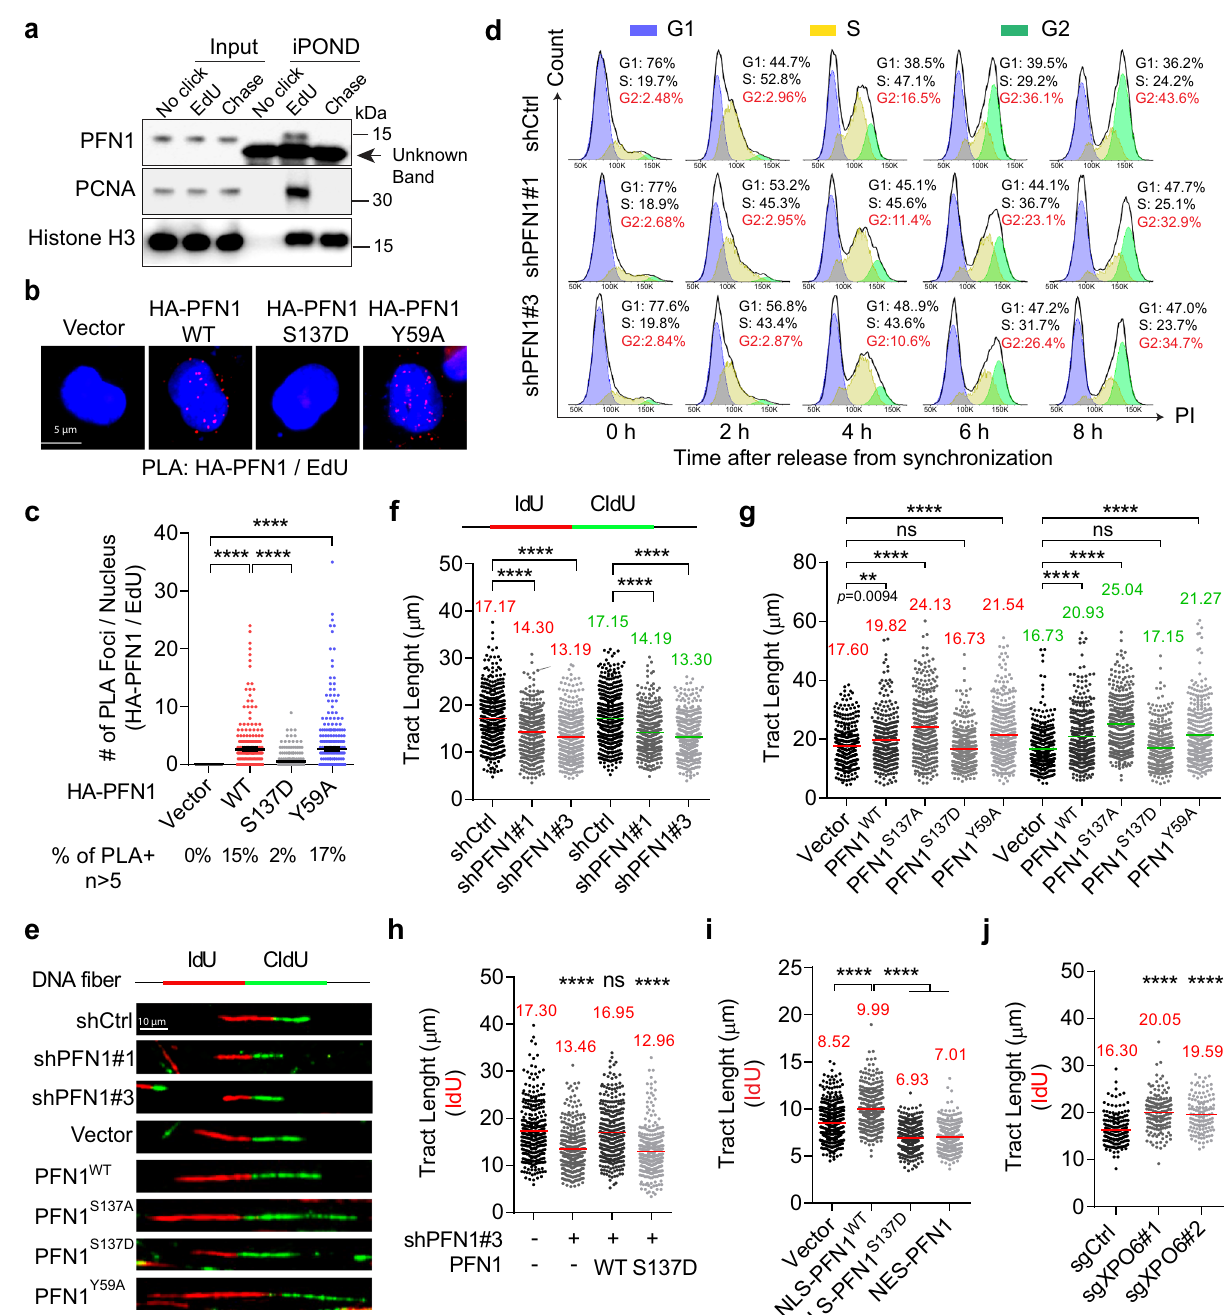
Fig. 1 | PFN1 is important for unperturbed DNA replication. a PFN1 is detected on nascent DNA by iPOND assay. HEK293T cells were labeled or not with EdU (10 µ M) for 25min, followed or not by thymidine (10 µ M) chase for 1h. b , c PLA between HA-PFN1 and biotinylated EdU in transfected HeLa cells. Scale bar, 5 µ m. Quanti fi cation (in c ) represents PLA foci numbers per nucleus out of at least 250 cells per condition. Error bars are mean±SEM. Percentages of PLA-positive cells (>5 foci per nucleus) are shown on the bottom. d Loss of PFN1 delays S phase progression.MCF-10AcellsinfectedwiththeindicatedshRNAsweresynchronized bydoublethymidineandreleasedfortheindicatedtimes.Thepercentagesofcells in G2 phase are colored in red. Samples were stained with propidium iodide and analyzed by fl ow cytometry and FlowJo. Gating strategies are provided in Sup- plementaryFig.10. e – g Representativeimages( e )andtractlengthanalysis( f , g )of